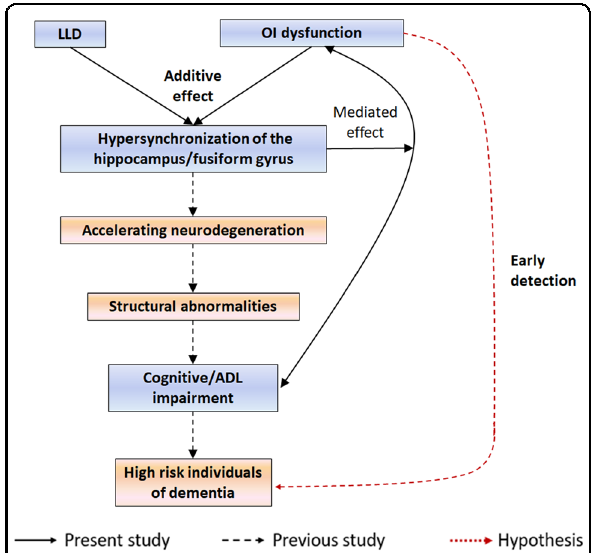
Fig. 5 Potential mechanism of how OI dysfunction increases the dementia risk of patients with LLD. OI dysfunction and LLD exhibited additive effects that resulted in hypersynchronization of the hippocampus/fusiform gyrus, which is a region related to olfaction, depression, and cognition. Persistent hypersynchronization may facilitate neurodegeneration and cause structural abnormalities, leading to cognitive impairment and ADL disability. In addition, the associations between OI dysfunction and cognitive impairment and ADL disability were mediated by hyperactivity of the hippocampus/ fusiform area. Overall, OI dysfunction may contribute to the early detection of individuals at high risk of dementia among patients with LLD. The blue box indicates the present analyses and the red box indicates future